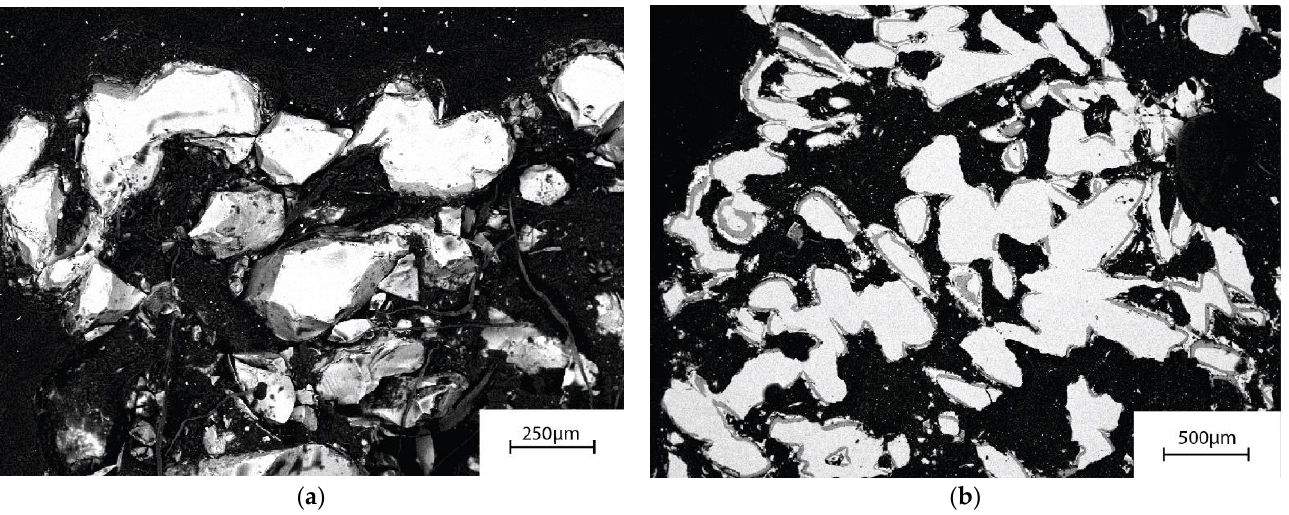
Figure 5. SEM images of cross-sections of an amorphous S53P4 scaffold after 7 days of the continuous ( a ) Tris and ( b ) SBF flow.